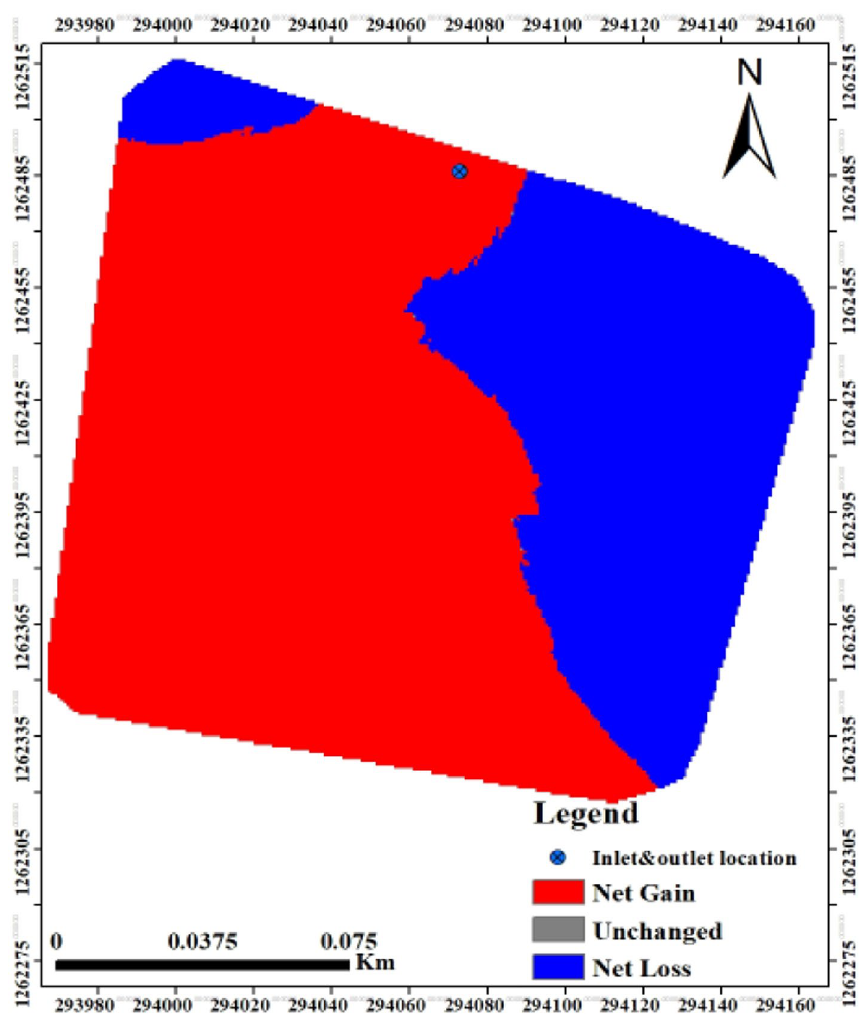
Fig. 13 Net gain and loss of Adebra NSR sediment volume